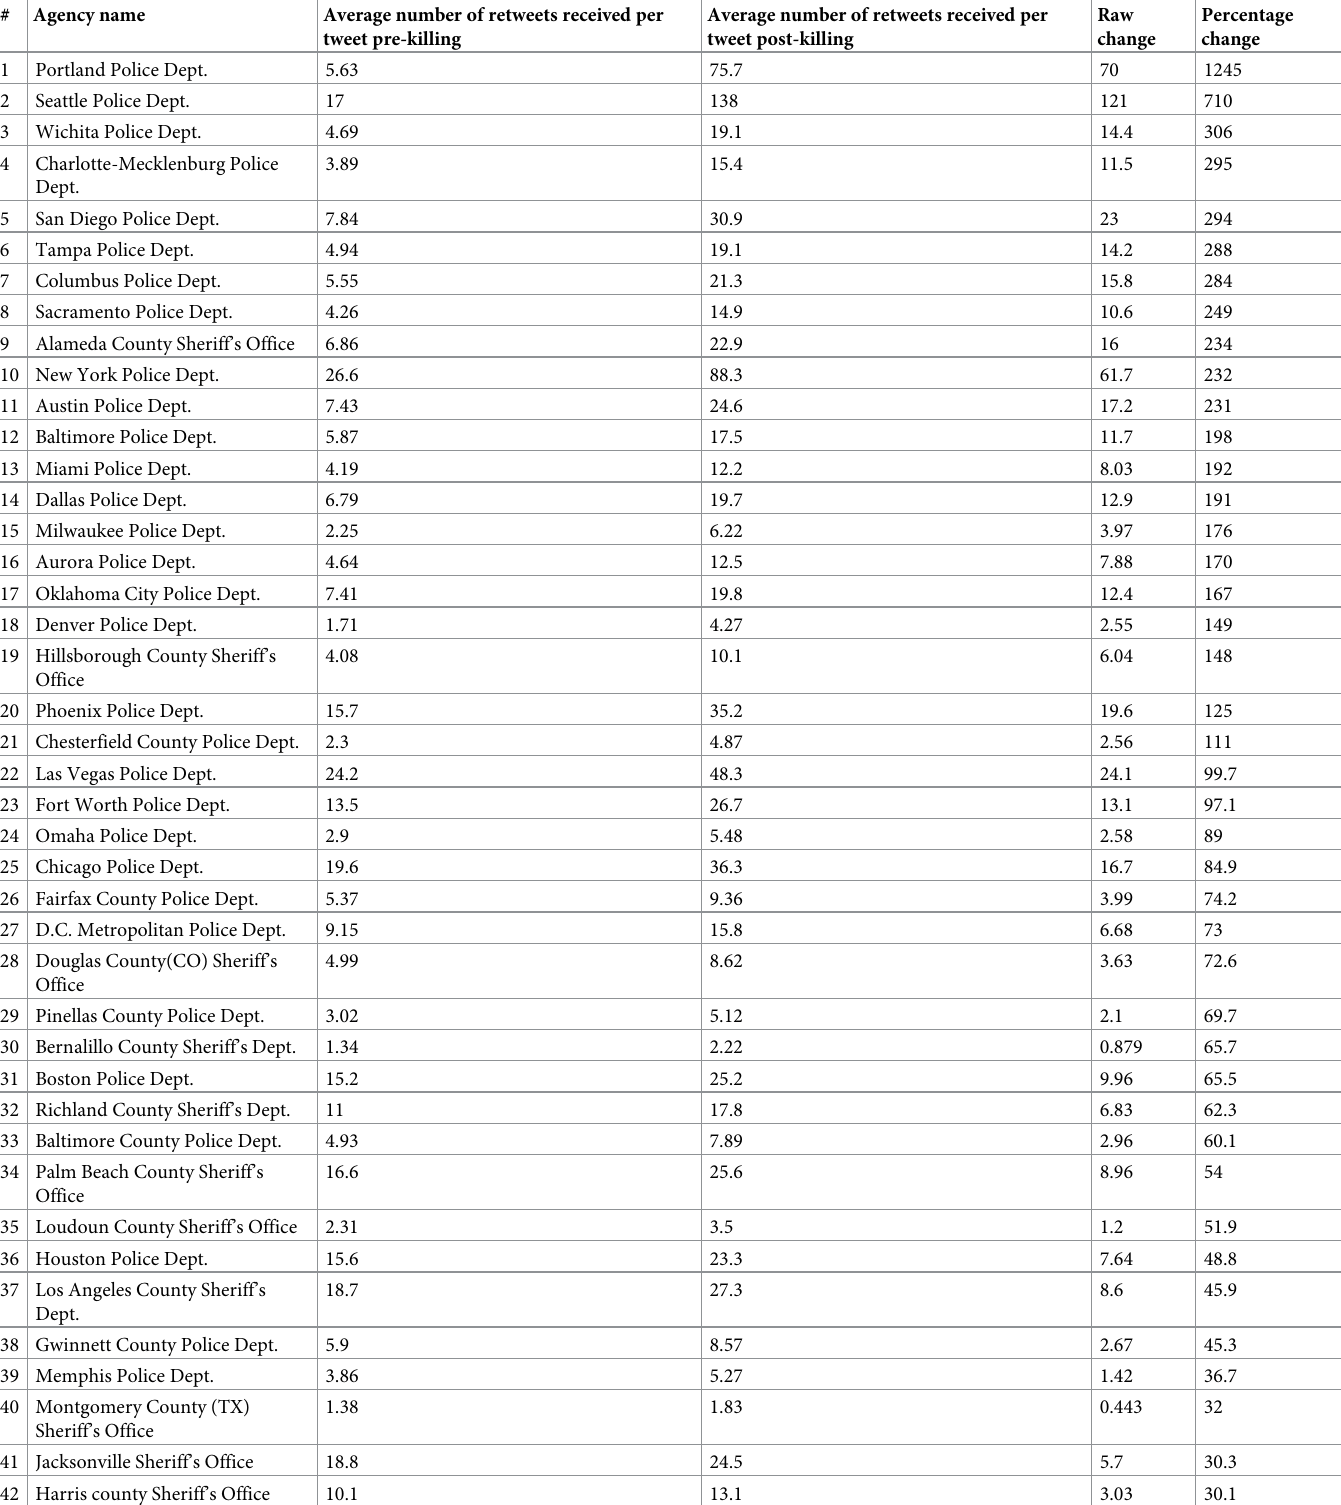
Table 7. Agencies (in the higher-use group) ranked by the increase in the received retweets per tweet before and after the killing. # Agency